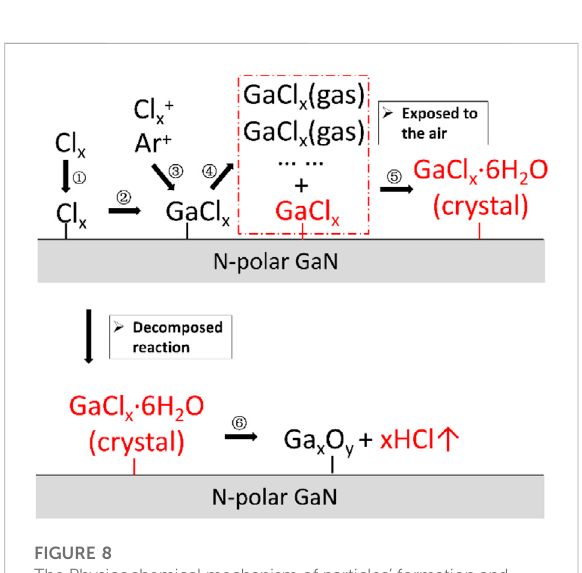
FIGURE 8 The Physicochemical mechanism of particles ’ formation and disappearance on N-polar GaN with conventional etch conditions in Figure 7